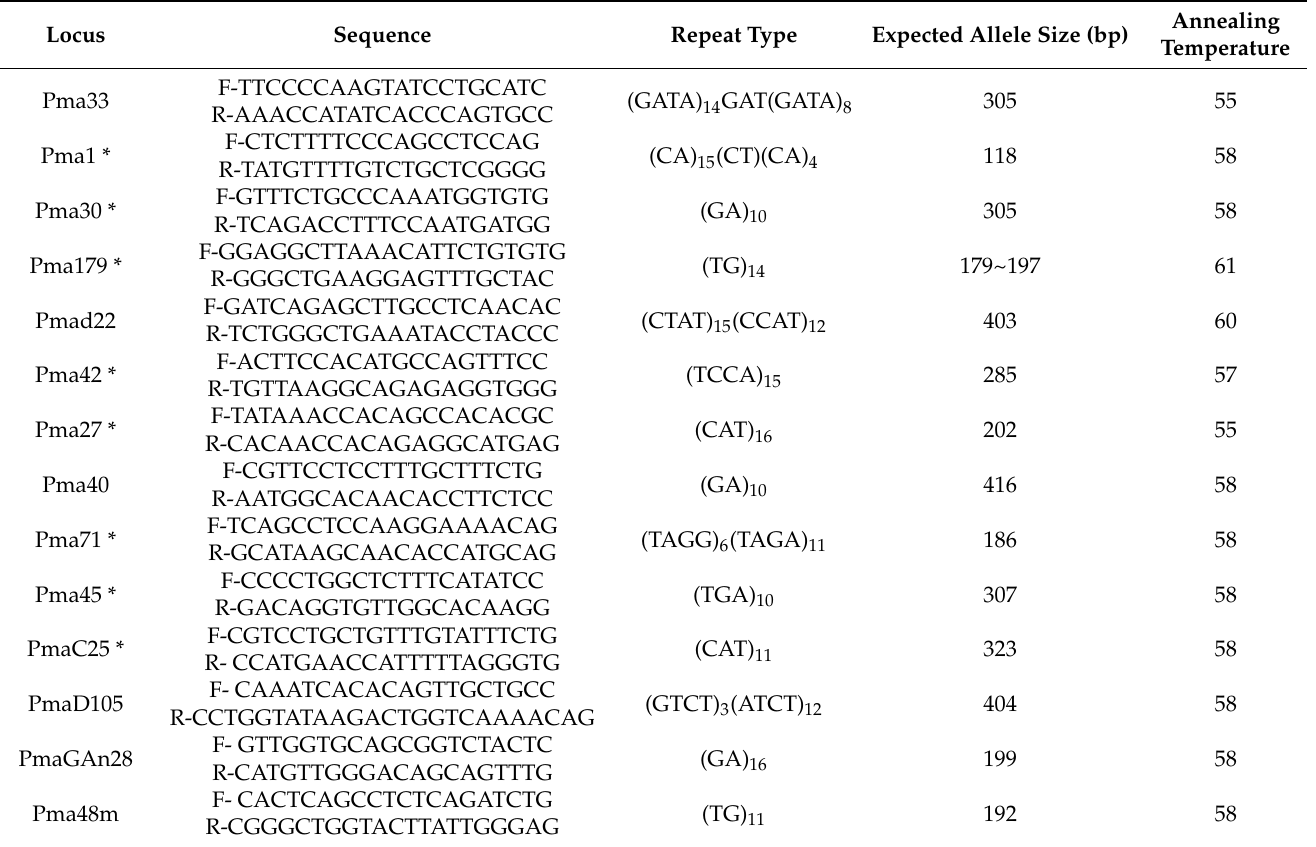
Table A1. Panel of 14 microsatellite markers used in the present study: a subset of 8 markers (denoted with an asterisk) was selected for parentage